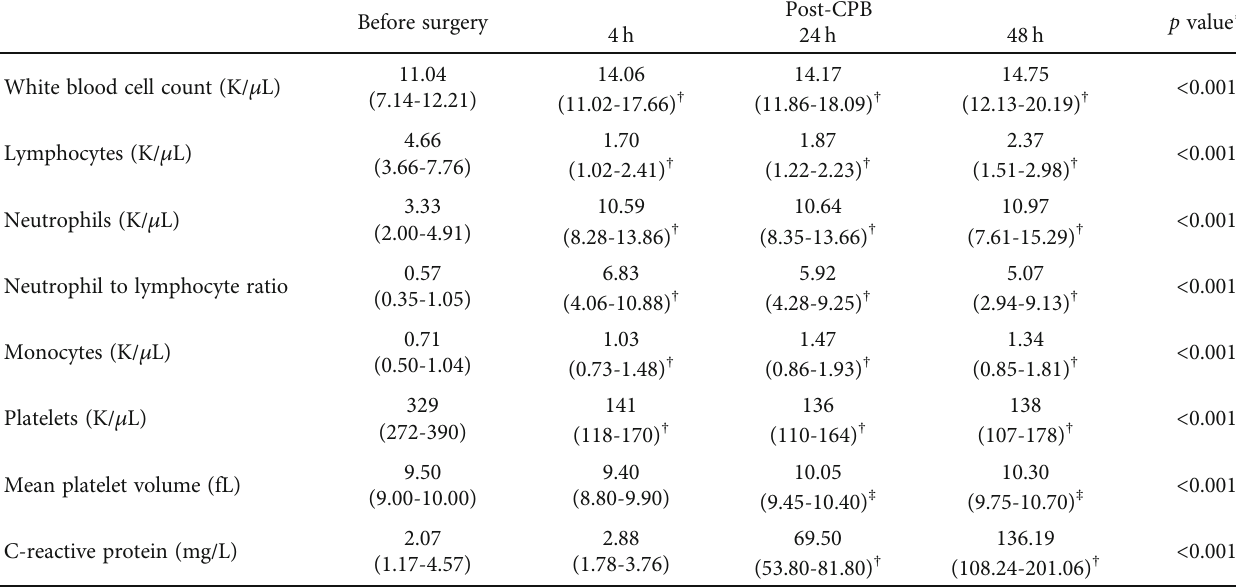
Table 3: Preoperative and postoperative hematological